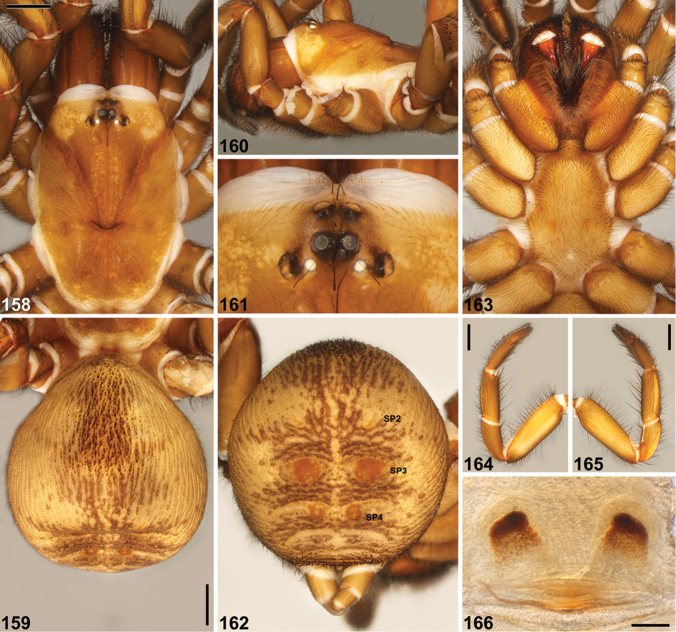

Idiosoma
formosum sp. n., female paratype (WAM T125751) from Mummaloo (Western Australia; AVW). 158–159 Carapace and abdomen, dorsal view 160 Carapace, lateral view 161 Eyes, dorsal view 162 Abdomen, posterior view 163 Sternum, ventral view 164 Leg I, prolateral view 165 Leg I, retrolateral view 166 Spermathecae, dorsal view. Scale bars 2.0 (158–159, 164–165), 0.5 (166). SP2–4 = sigilla pairs 2–4.